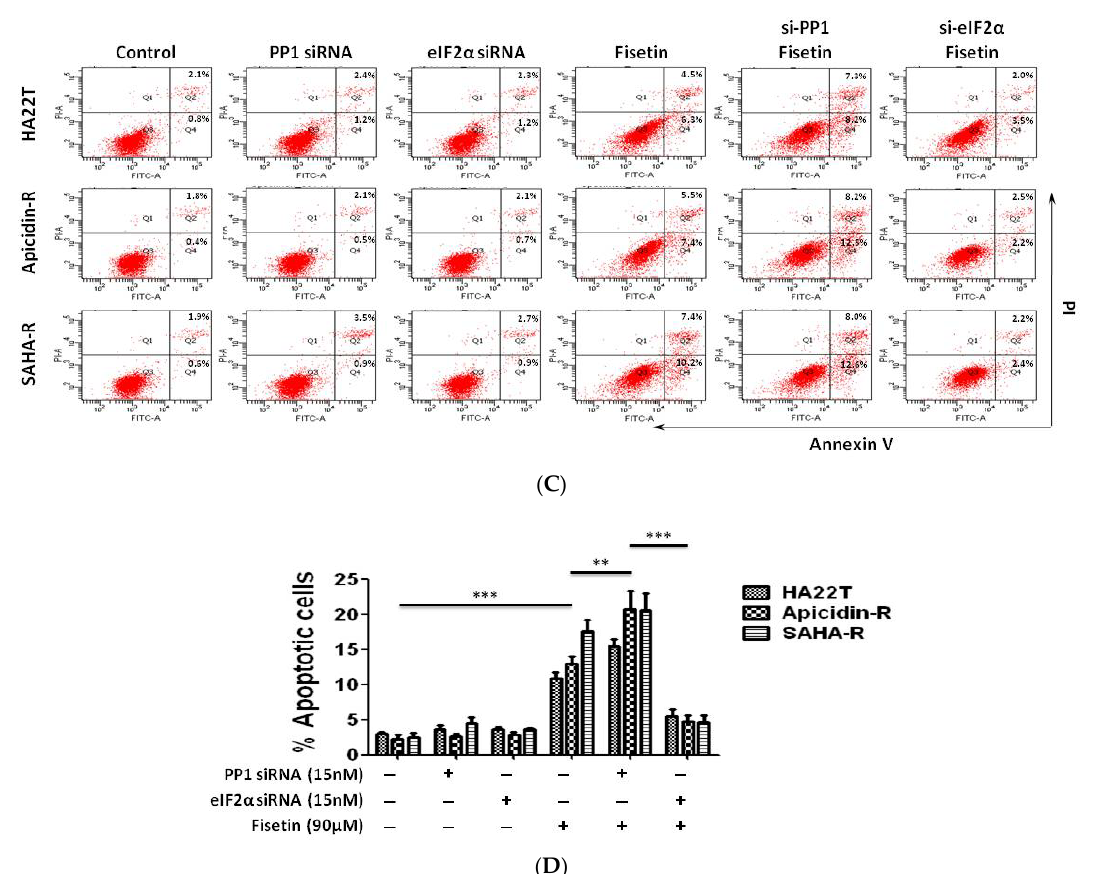
Figure 6. Knockdown of eIF2α by gene silencing inhibits the extraordinary apoptosis effect in HCC. ( A , B ) siRNA knockdown of eIF2 expression downregulated p-eIF2 α expression, and levels of cleaved caspase 3 or cleaved PARP also decreased, which promoted cell survival. Quantification of western blot using ImageJ, normalized to GAPDH. * p < 0.05, ** p < 0.01, *** p < 0.001 compared with the control group. ( C ) After the regulated expression of PP1 or eIF2α and treatment with or without fisetin to check cell apoptosis in liver cancer cells by flow cytometry. ( D ) Quantification of Figure 6C. Data indicate the percentage of apoptotic cells (annexin-V positive + annexin-V and propidium iodide (PI) double positive cells) (* p < 0.05, ** p < 0.01, *** p < 0.001) compared with the nontreatment group.